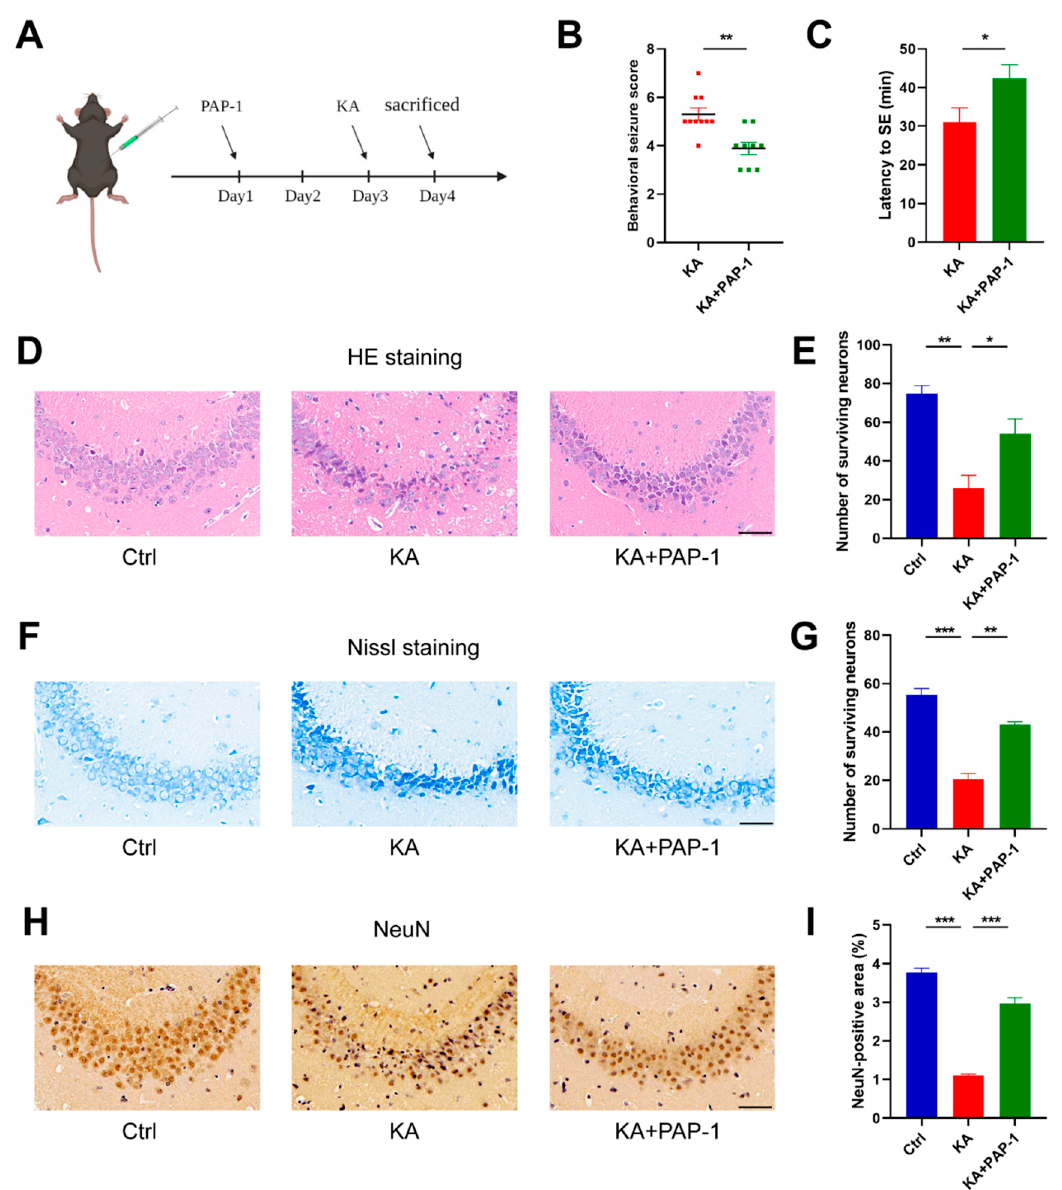
Figure 2. PAP-1 attenuated epileptic seizures and hippocampal neuronal damage in KA-induced mouse epilepsy model. ( A ) Flowchart of the experiment in vivo. ( B ) Seizure severity of mice after KA treatment in the presence (n = 9) or absence of PAP-1 (n = 10); statistics by Mann–Whitney test. ( C ) Seizure latency to SE; statistics by unpaired t -test. ( D , F , H ) Representative HE, Nissl, and NeuN staining of the hippocampal CA3 region. Scale bar: 50 µ m. ( E , G , I ) Surviving neurons of each group were counted (n = 3); statistics by one-way ANOVA with Tukey’s multiple comparisons test; HE, F (2, 6) = 14.50, p = 0.0050; Nissl, F (2, 6) = 68.07, p < 0.0001; NeuN, F (2, 6) = 148.3, p < 0.0001. Data